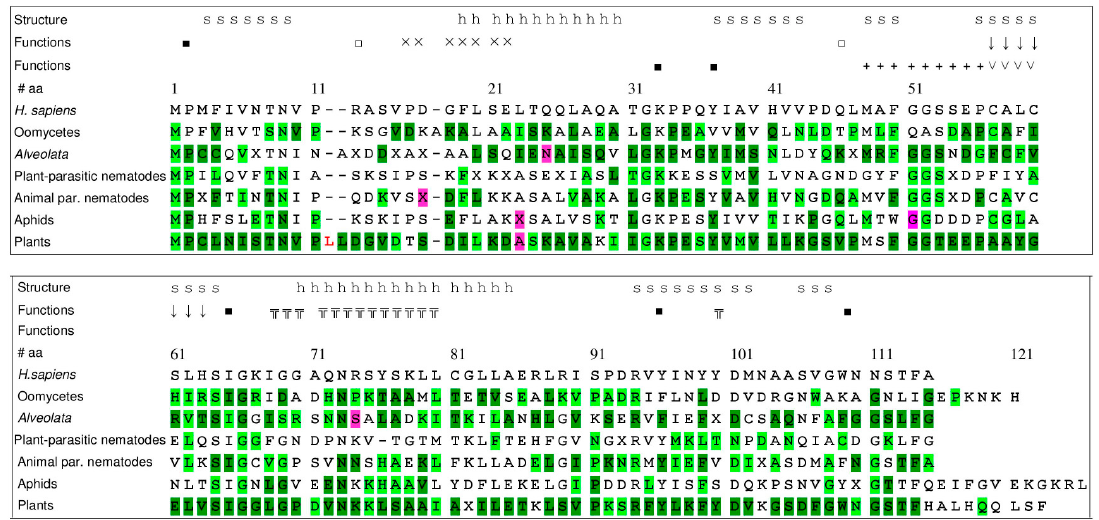
Figure 6. Conservation of amino acid sites and motifs in consensus MIF sequences. Alignment (amino acid one letter code) of human MIF sequences and consensus sequences of oomycetes, Alveolata , plant-parasitic nematodes, animal-parasitic nematodes, aphids and plants. Amino acid numbers are given above the human sequence. Hyphens (-) indicate a gap in the respective sequence. Consensus sequences, obtained using Jalview version 2.9, show the most frequent amino acids at each position, or an X when the frequency of the most prominent amino acid is below 40%. Sites under purifying or diversifying selection are colored as follow: pink = purifying selection predicted by 4 to 5 selection algorithms; light green = purifying selection predicted by two to three selection algorithms; dark green = purifying selection predicted by four to five selection algorithms. α helices and β sheets of human MIF are indicated by the letters ‘h’ and ‘s’, respectively. Amino acids shown to determine specific functions or activities in human MIF are specified by symbols above the sequence. They are involved in the tautomerase activity ( ■ symbol), oxidoreductase activity (CXXC motif; ˅ symbol), binding to the CXCR4 receptor ( ╦ symbol), binding to the CXCR2 receptor (pseudo ELR motif; □ symbol), interaction between MIF and the CXCR2 receptor (N like loop pattern; + symbol), nuclease activity (PE/DxxxxE motif; x symbol) and DNA damage response protein. (CxxCxxHx(n) zinc finger domain; ↓ symbol).